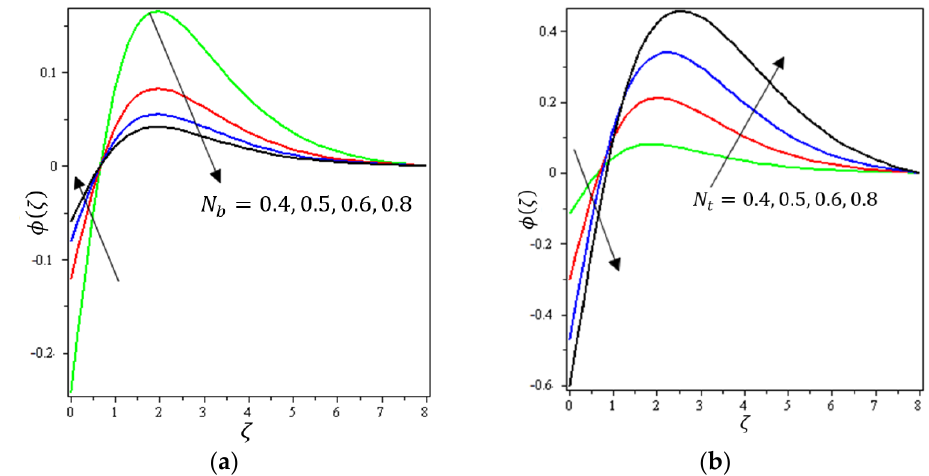
Figure 11. Influence of ( a ) Brownian movement 𝑁 (cid:3029) and ( b ) thermophoretic diffusion 𝑁 (cid:3047) on 𝜙(𝜁) .